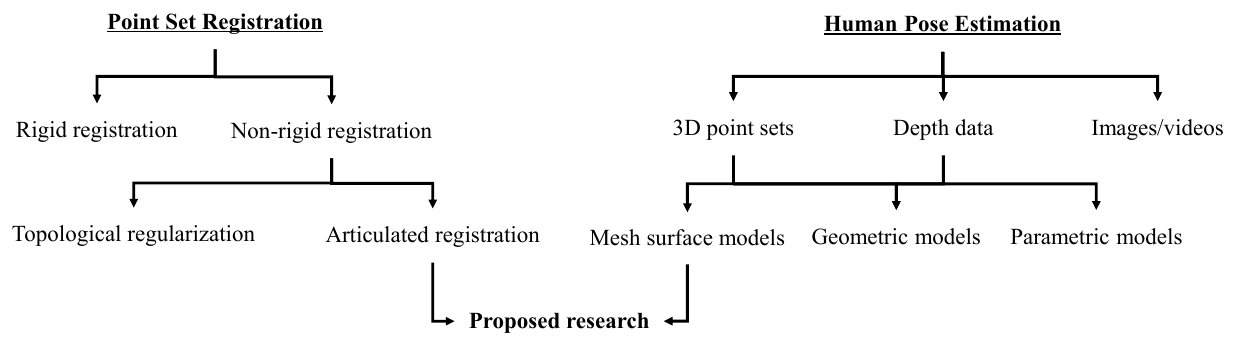
Figure 1. Related work in terms of point set registration and human pose